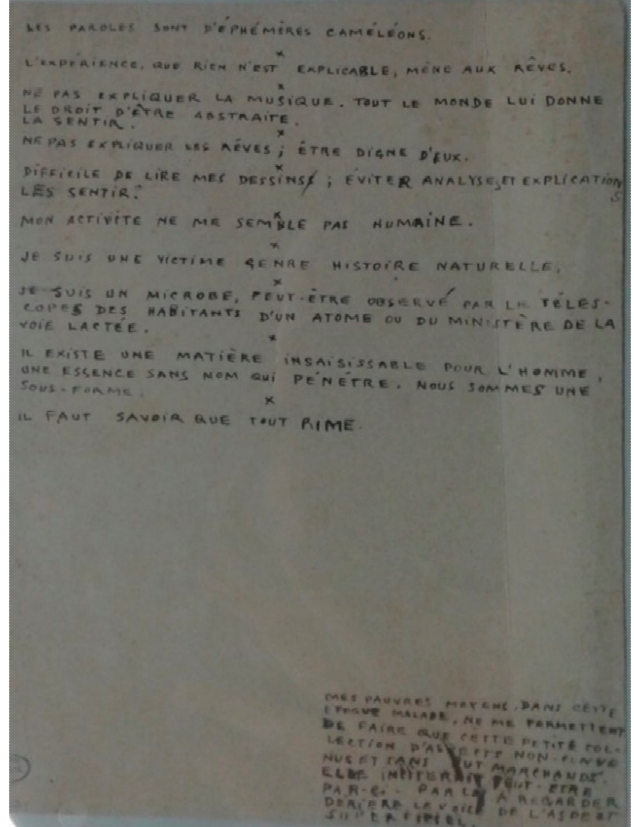
Figure 10. Aphorisms/Project for a book? Dieulefit, 1941–1944. Archive Wols, fund Iliazd 3871, Bibliothèque Kandinsky/MNAM. © Adagp, Paris, 2020/Courtesy Bibliothèque Kandinsky.